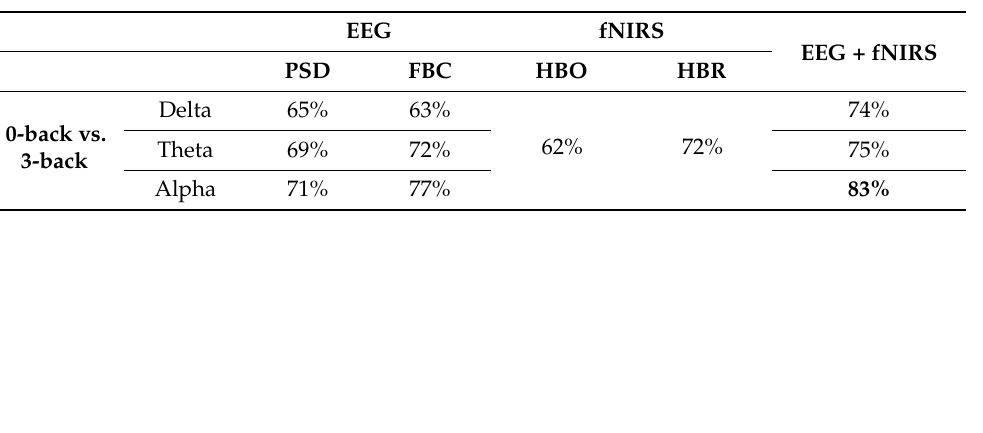
Table 3. SVM classification accuracy of 0 ‐ back vs. 3 ‐ back using different features.